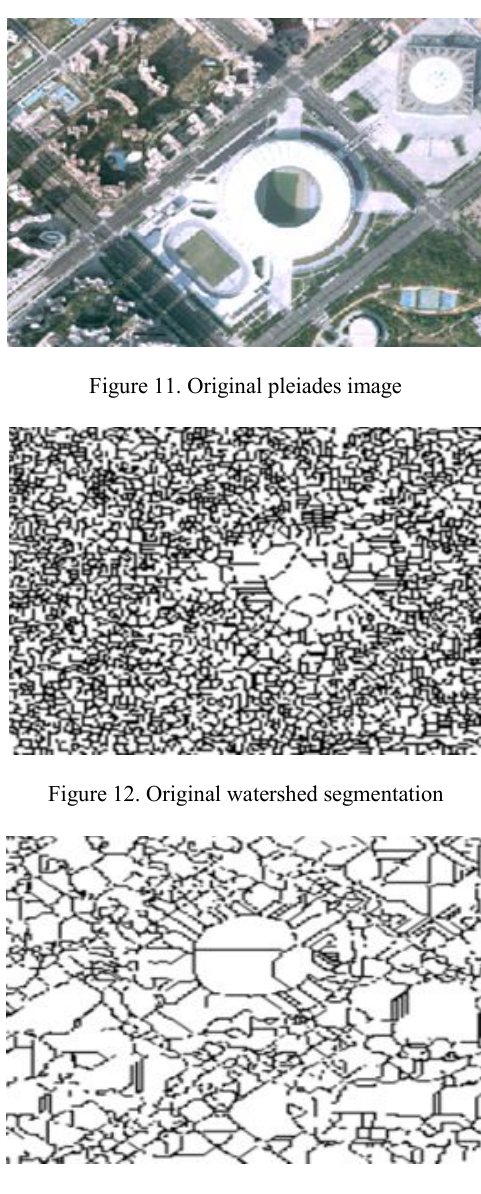
Figure 13. Improved watershed segmentation